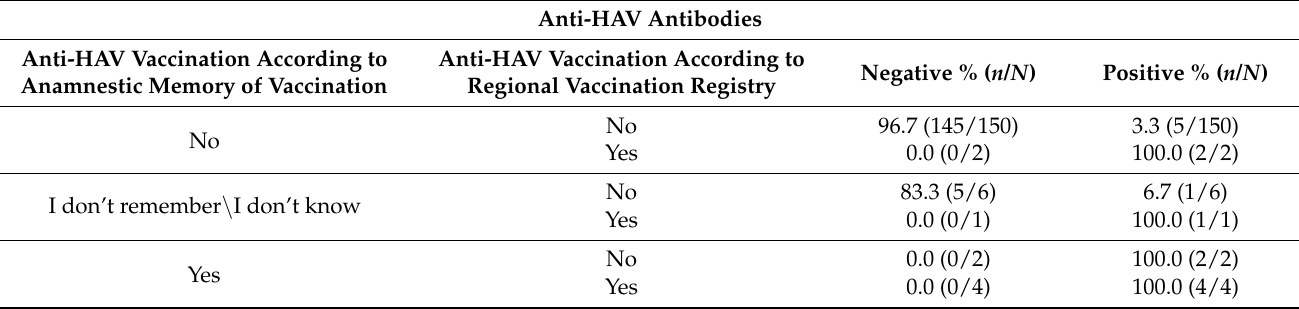
Table 6. Concordance between anamnestic memory of vaccination and data from the regional vaccination registry. Anti-HAV Antibodies Anti-HAV Vaccination According to Anamnestic Memory of